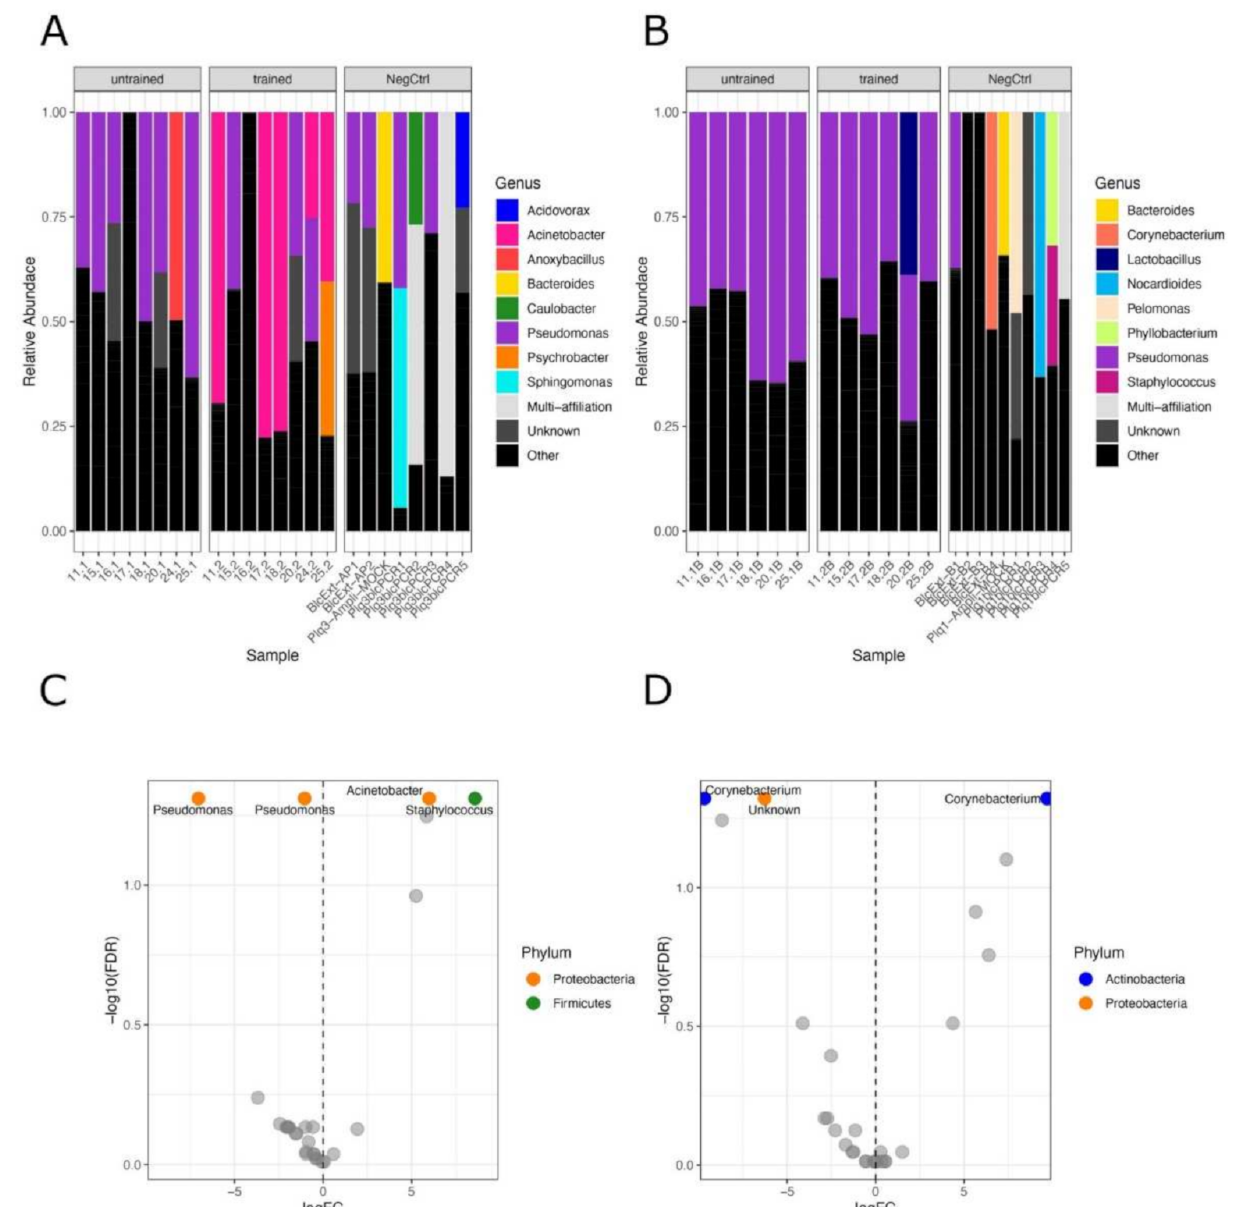
Figure 3. Phylogenetic distribution of bacteria in tissues before and after training: Stacked bar plots showing the phylogenetic distribution of bacteria at the genus level before and after training across participants in muscle ( A ) and in the blood ( B ). The NegCtrl panels show the phyla relative abundances of concomitant controls samples. C and D, Volcano plots displaying the differentially abundant genera before and after exercise in muscle ( C ) and blood ( D ), obtained by statistical differ- ential abundance analysis performed with edgeR. Labelled OTUs are significant ones, FDR <